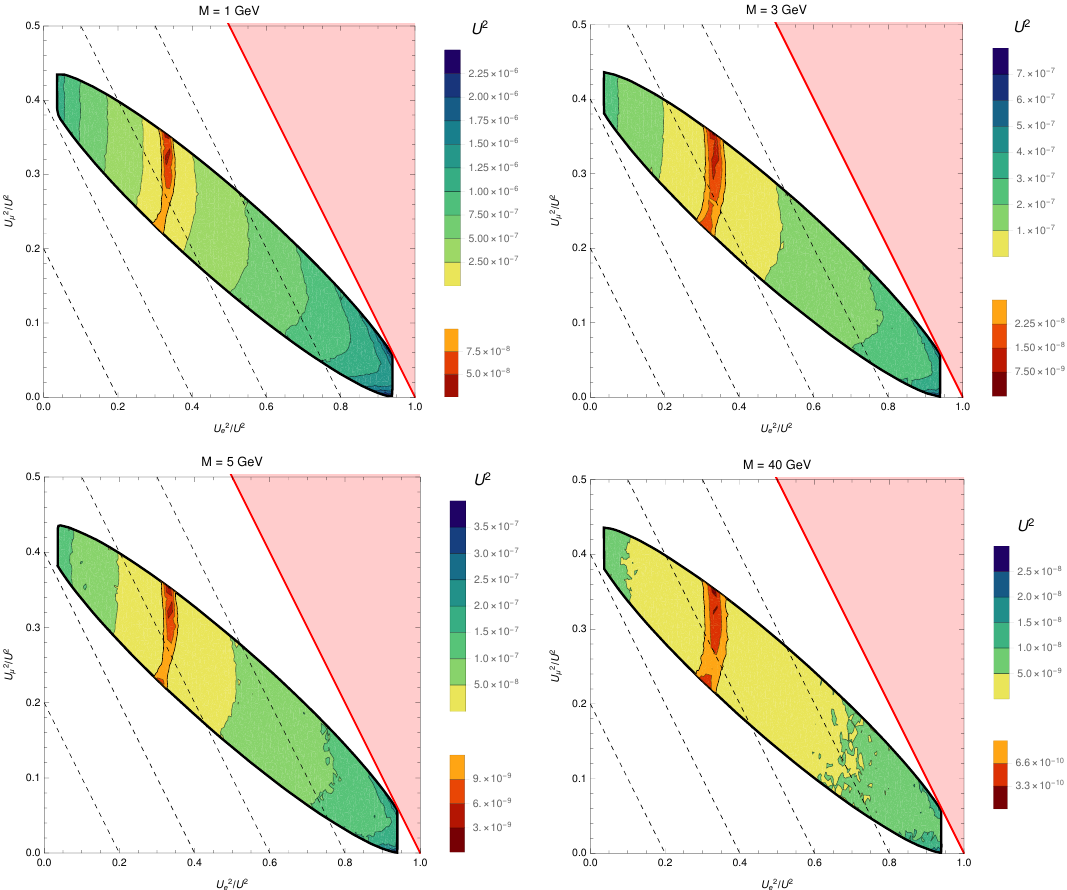
Figure 9 . Same as (cid:12)gure 8, but for inverted hierarchy. (The thick black lines display the region consistent with neutrino oscillation data, cf. the bottom panel of (cid:12)gure 1.) The region near the point U 2 = U 2 = U 2 is forbidden because it does not lead to a (cid:13)avour asymmetric washout, which e (cid:22) (cid:28) is required to generate a total L 6 = 0 for n s =